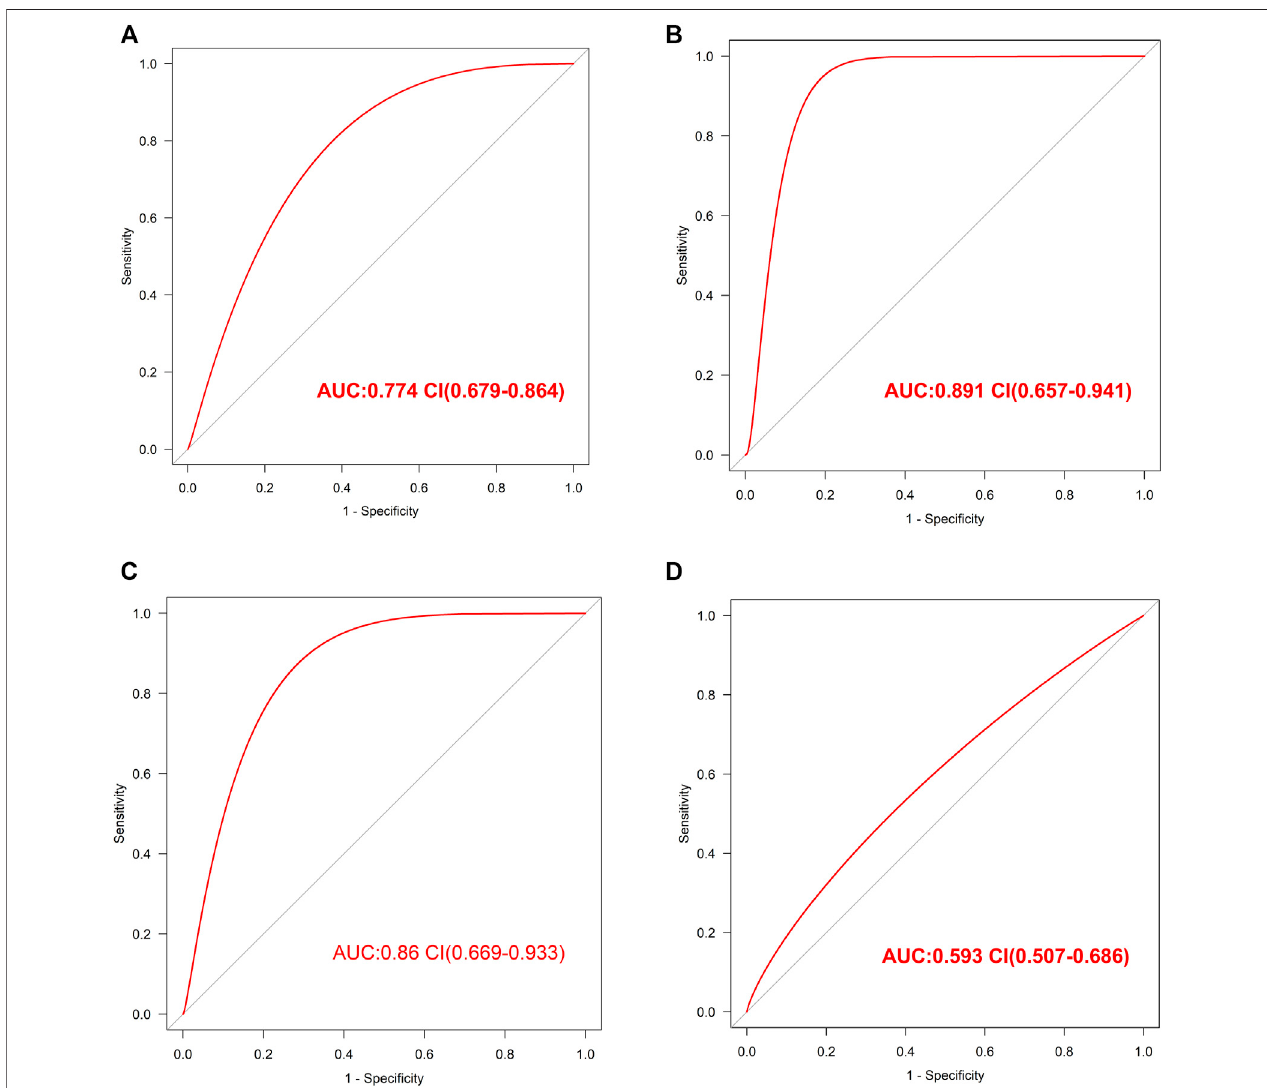
FIGURE4| Thevalidationofthis diagnostic model (A) . The ROCvalue ininternal validationofthis diagnostic model (B) . TheROCvalue inexternalvalidation ofthis diagnostic model by GSE76826 dataset (C) . The ROC value in validation of this diagnostic model by GSE53987 dataset (D) . The ROC value in validation of this diagnostic model by GSE38484